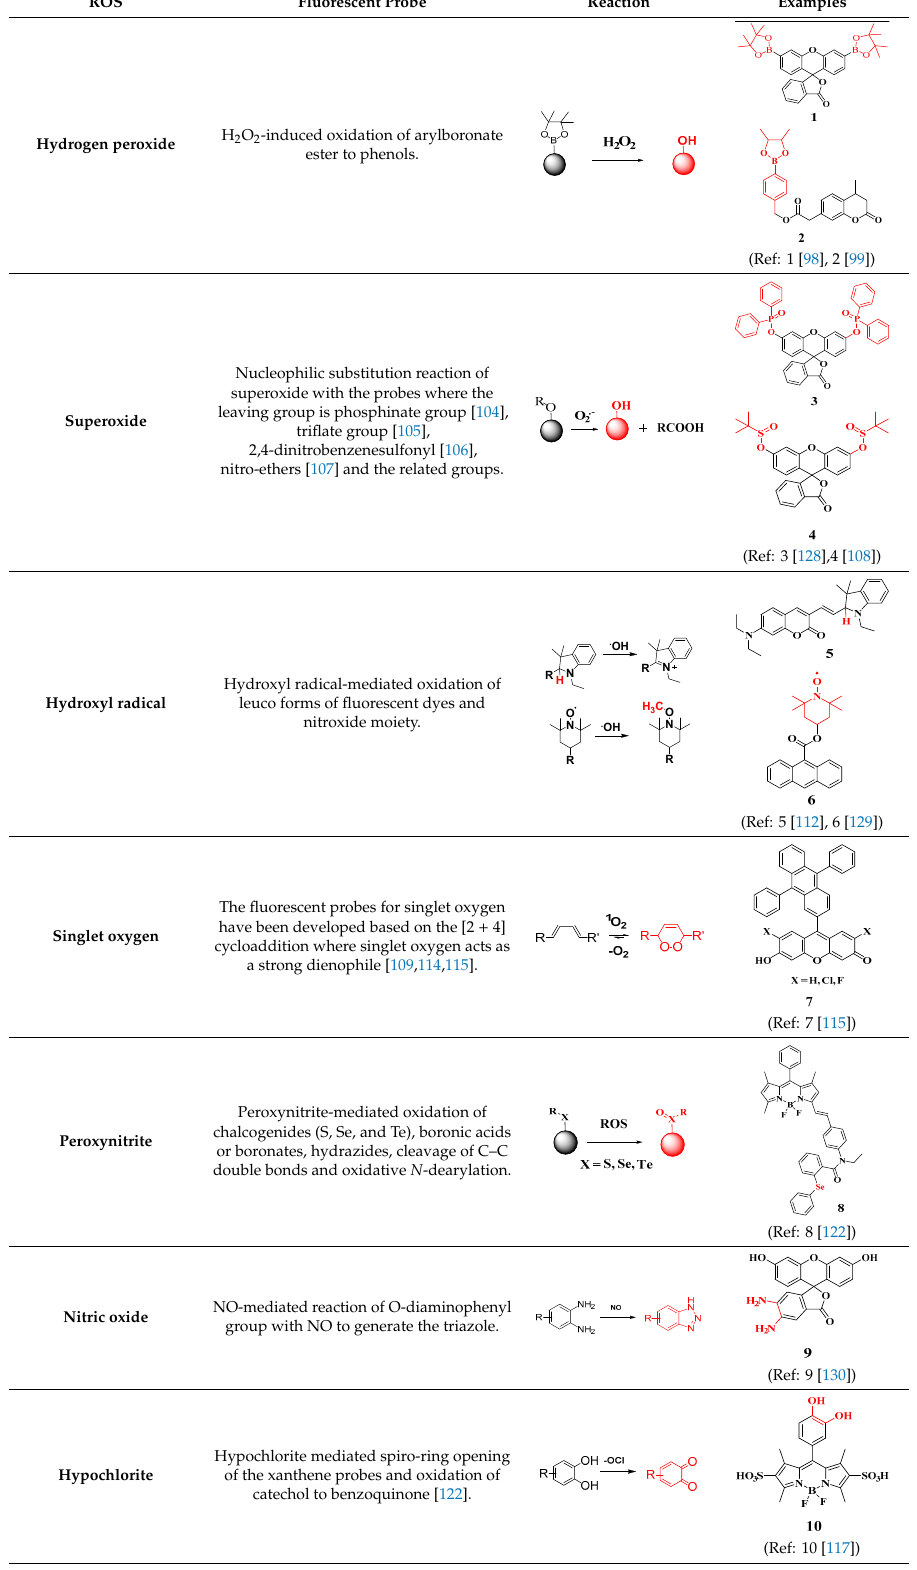
Table 2. ROS and their mode of detection using fluorescent probes.